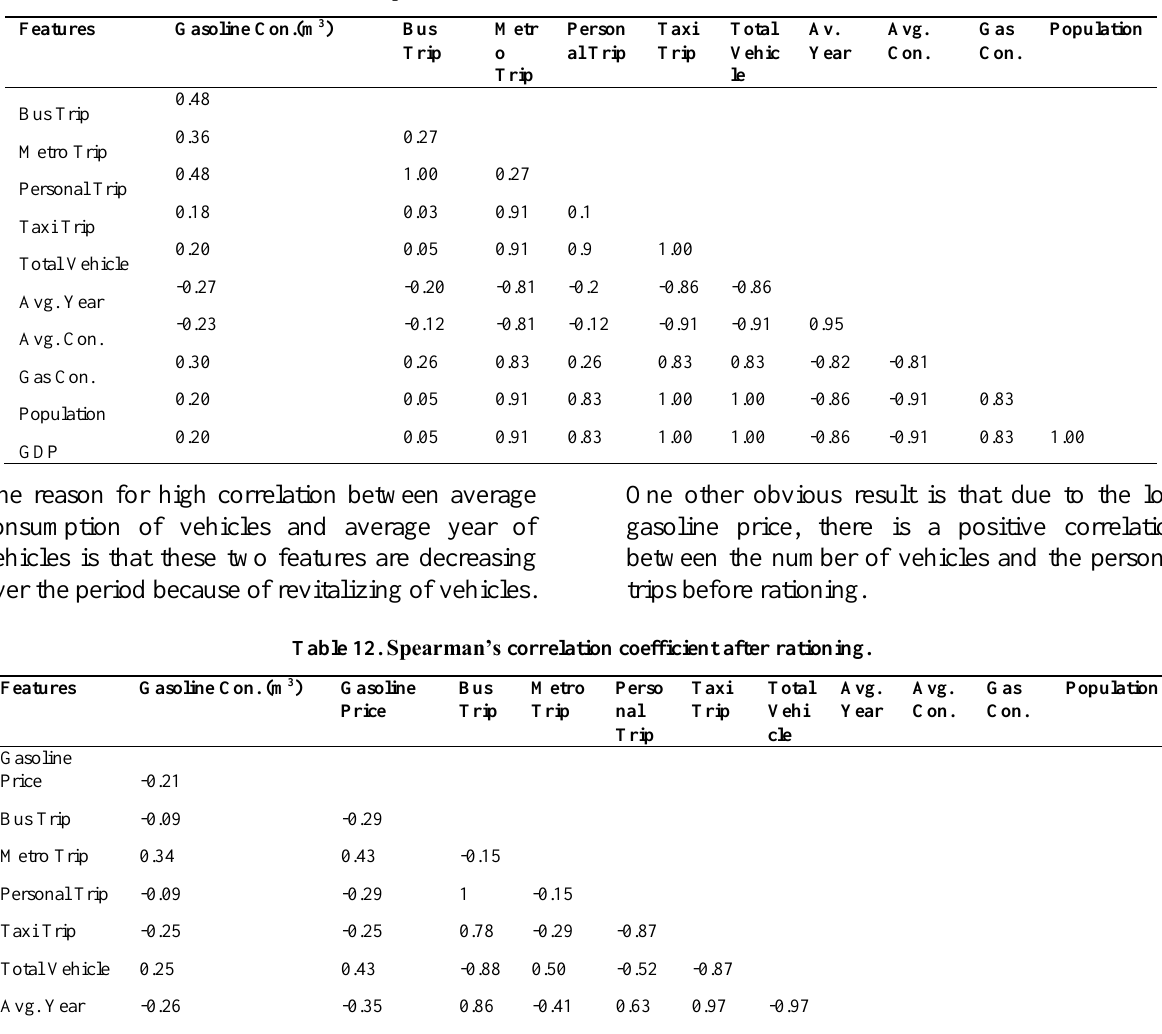
Table 11. Spearman’s correlation coefficient before rationing.